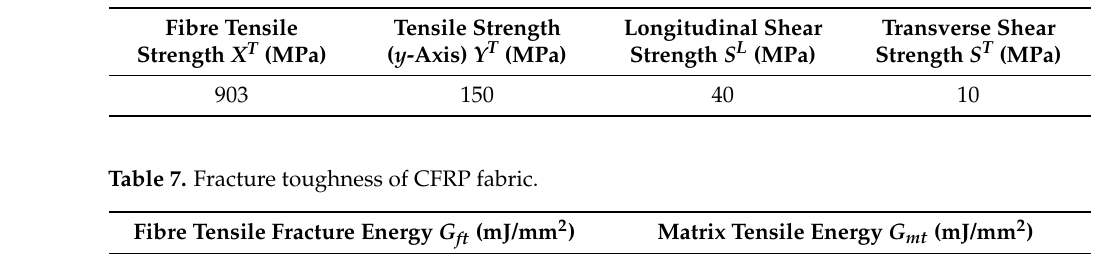
Table 6. Strength of CFRP fabric.